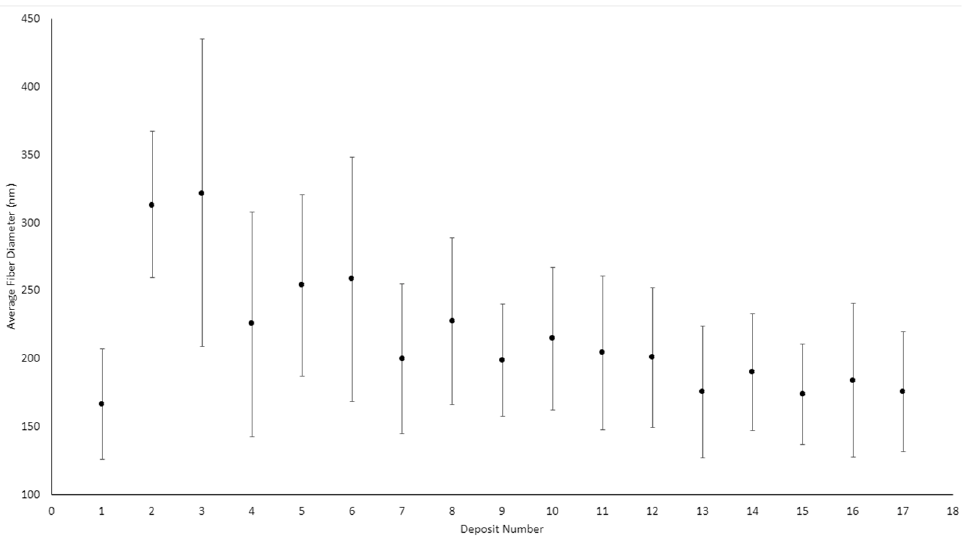
Figure 7. Average fiber diameters for parallel-plate configuration (deposits 1–9) and needle–plate configuration (deposits 10–17).